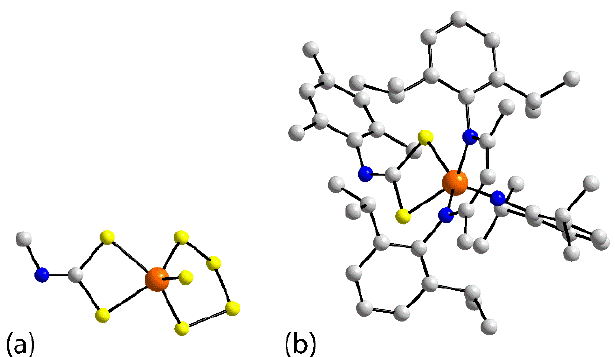
Figure 3. Molecular structures of ( a ) the {(S 4 )Re(=S)[S 2 C=N(Me)]} − anion in 6 and ( b ) [(2,6- (iPr) 2 C 6 H 3 )NC(Me)=C(H)C(Me)=N(2,6-(iPr) 2 C 6 H 3 ]Re[=N(2,6-(iPr) 2 C 6 H 3 )][S 2 C=N(Mes)] ( 7 ).